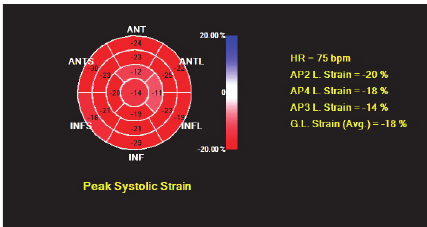
Figure 4: Abnormal longitudinal strain function confined to the left ventricular